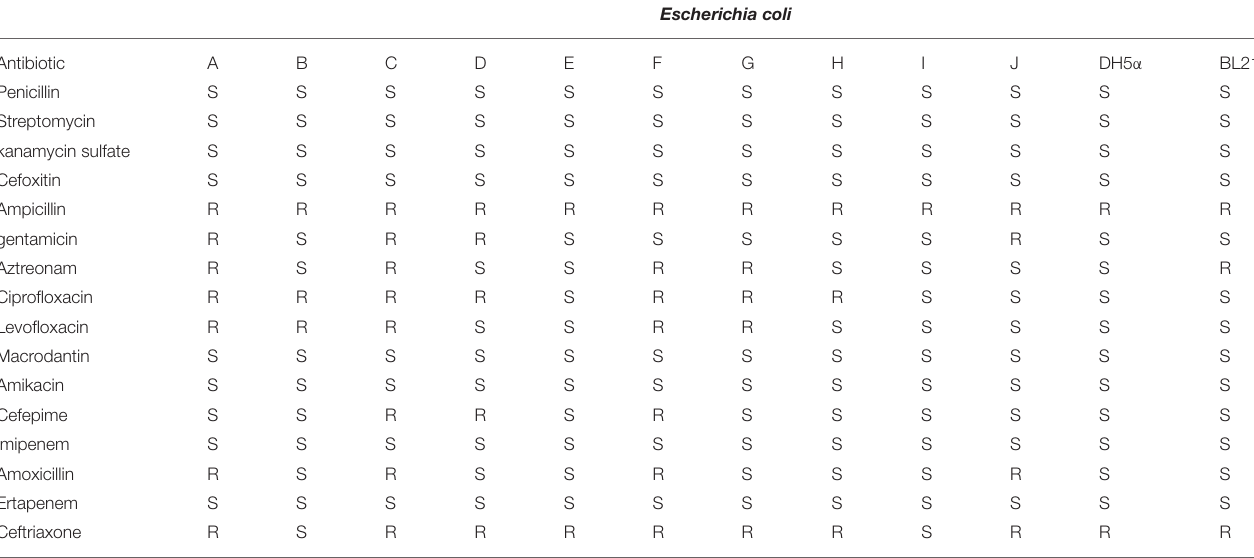
TABLE 1 | Antibiotic resistance of Escherichia coli isolates used in this study.